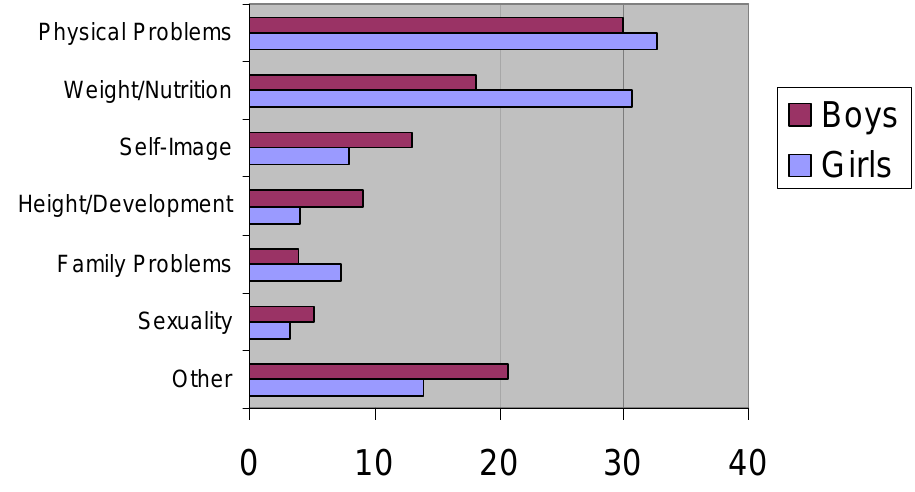
FIGURE 1 . Topics requested for discussion; 7th graders (n =